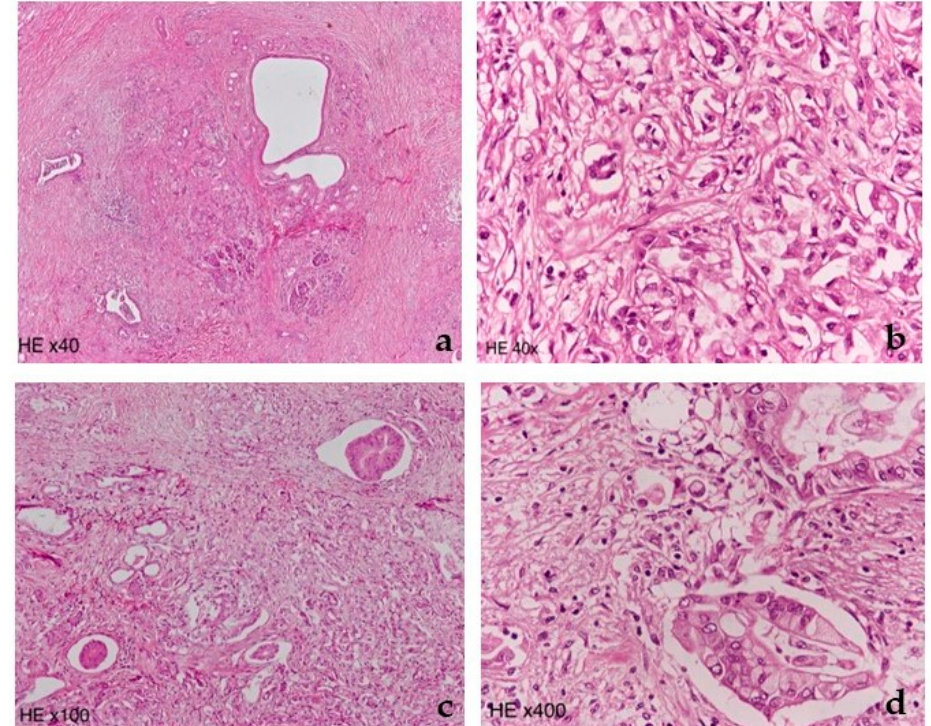
Figure 6. ( a , b ) Pancreatic head tumor; ( c , d ) Pancreatic tail tumor. Hematoxylin and eosin stains, (40 × –400 × magnifications), show the two moderately to poorly differentiated adenocarcinomas of the pancreatic head and tail at different magnifications. The atypical neoplastic glandular structures surrounded by desmoplastic stroma can be appreciated in the ( a ) head and ( c ) tail in low magnification. The neoplastic cells with irregular atypical nuclei, prominent nucleoli, and abundant eosinophilic and clear cytoplasm can be appreciated in ( b ) head and ( d ) tail in high magnification. Immunohistochemically, the neoplastic cells were positive for CA19-9, CEA, CK7, and to a lesser degree, CA125 (Figure 7), while being negative for